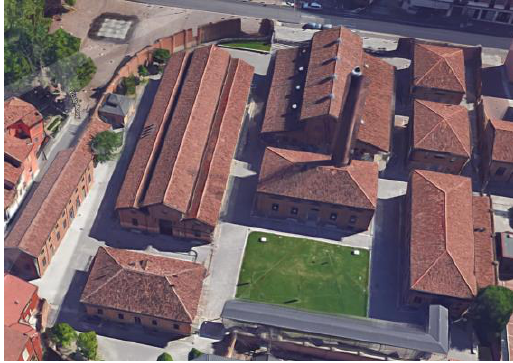
Figure 2. The S. Anna complex in Piacenza.